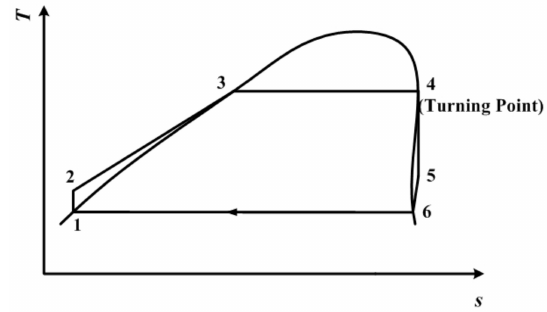
Figure 4. Traditional subcritical ORC with dry / isentropic working